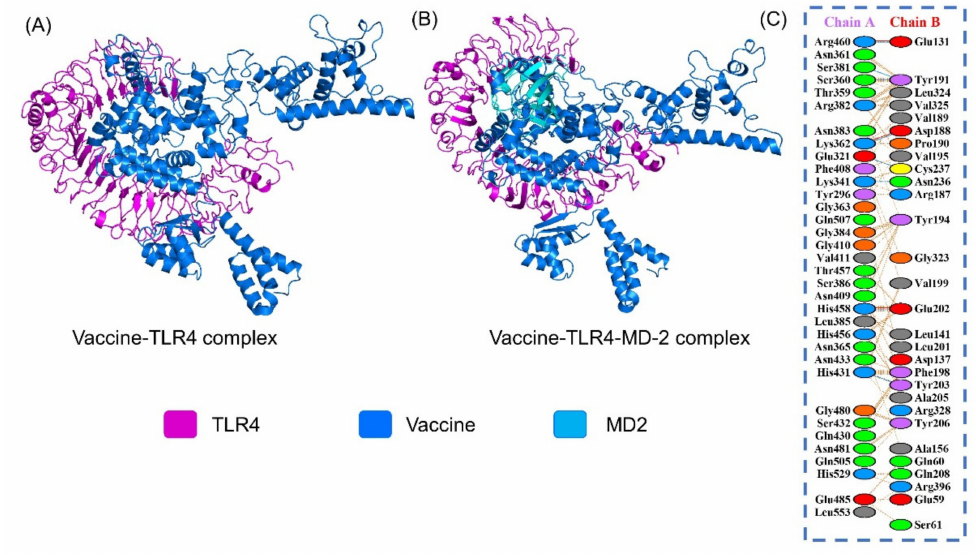
Figure 7. ( A ) Vaccine-TLR4 docked complex. ( B ) Vaccine-TLR4-MD2 docked complex. The receptor TLR4 is colored as magenta to contrast the blue color vaccine. The MD2 is shown as cyan in panel ( B ). The complex is also shown as a sphere. ( C ) Interacting residues are also given as right